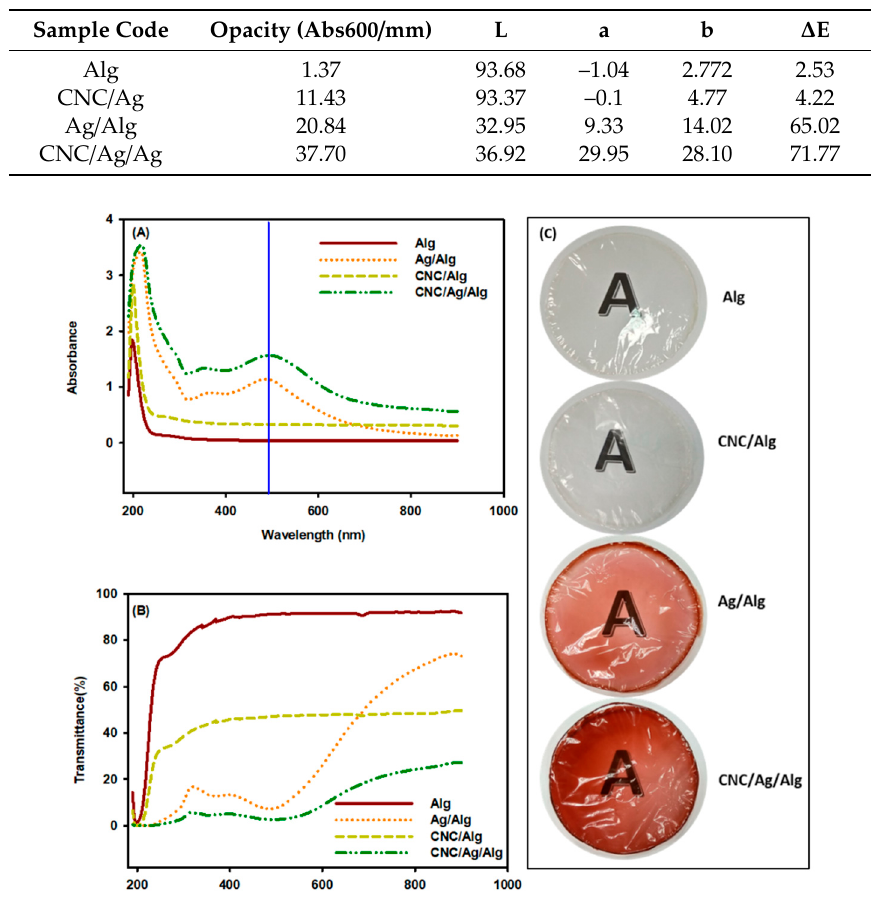
Figure 7. Ultraviolet (UV) spectra for ( A ) absorbance, ( B ) transmittance, and ( C ) visual observation (transparency) of biocomposite films.